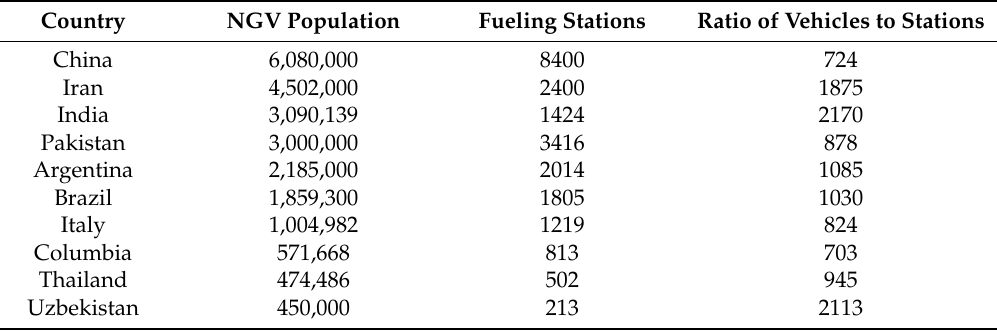
Table 5. Top 10 countries by the number of fueling stations